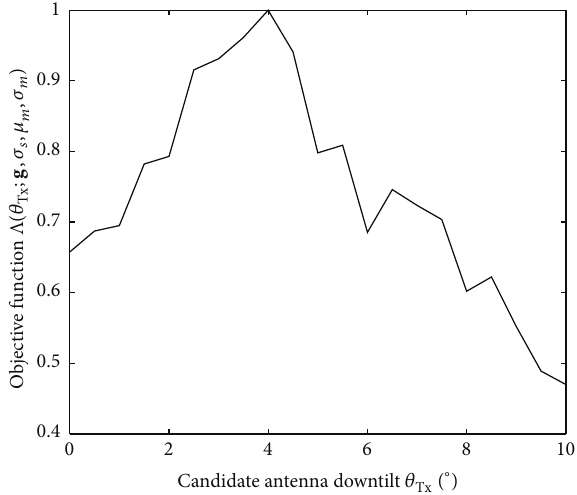
Figure 7: An example of the objective function of downtilt calcu- lated in a simulation with the true downtilt 𝜃 󸀠